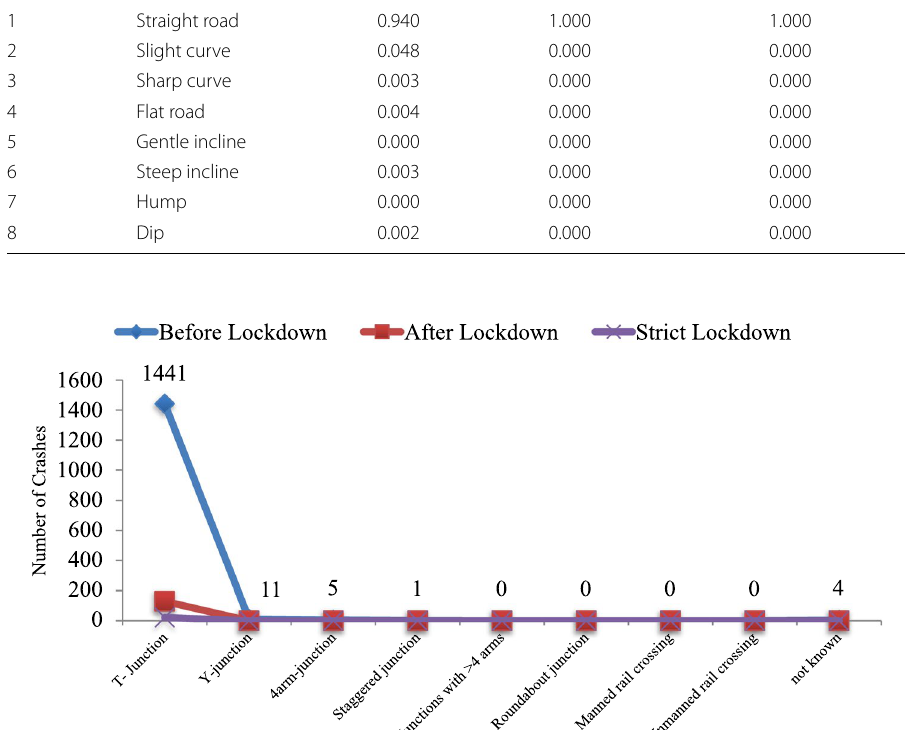
Fig. 7 Analysis of crash data by intersection type and